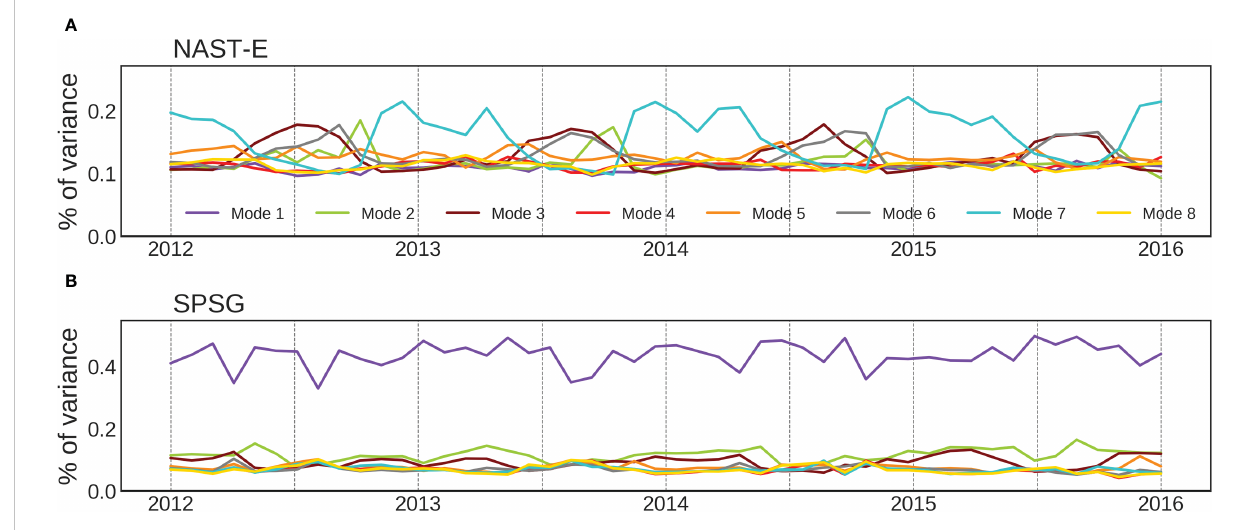
FIGURE 8 Temporal evolution of the percentages of variance explained by the 8 modes of the CNN MM8 in two BGCPs with contrasting entropy: (A) in the eastern North Atlantic Subtropical Gyre (NAST-E, [35°N – 42°N; 15°W – 30°W]) and (B) in the SPSG ([20°S – 30°S; 95°W – 145°W]). The colors correspond to the modes as in Figure